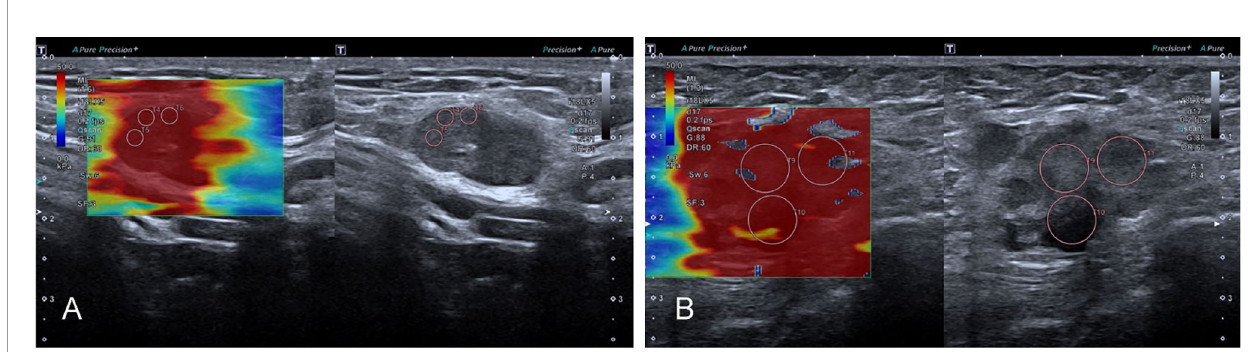
FIGURE 4 | The SWE images of malignant LNs, with pathological results proven metastatic LN in the right axilla (A) and metastatic LN in the left axilla of breast cancer (B) ,